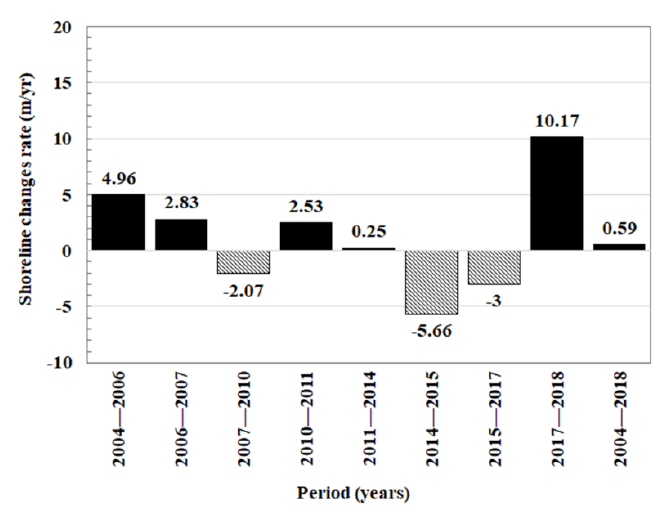
Figure 6. Rate of shoreline change at Pattaya beach.